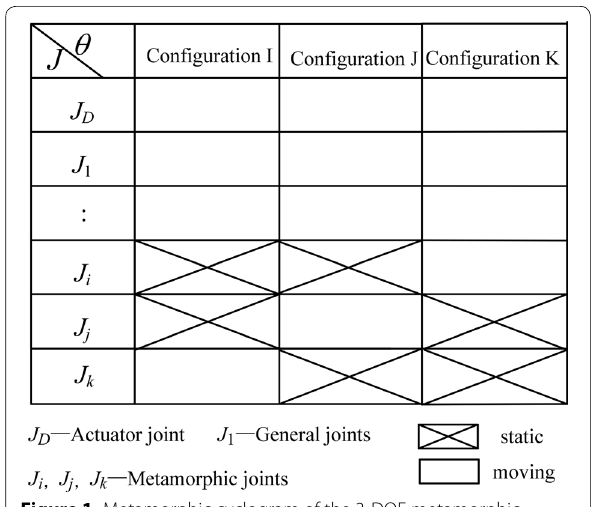
Figure 1 Metamorphic cyclogram of the 3-DOF metamorphic